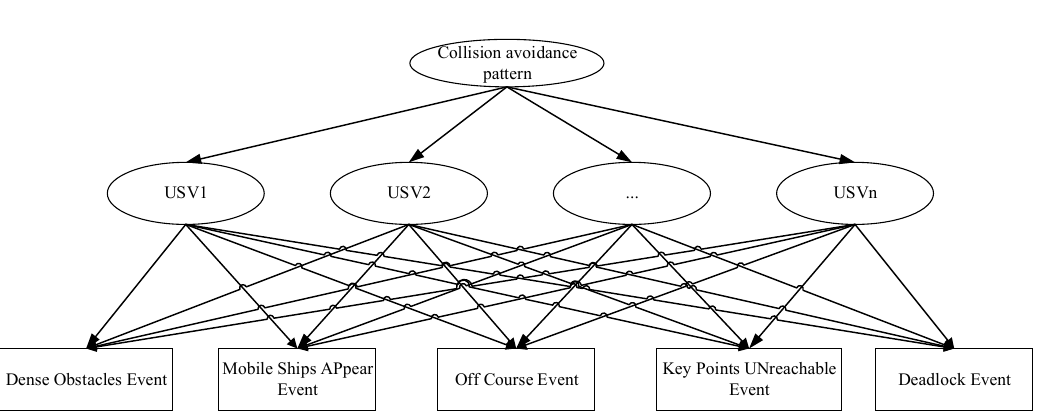
Figure 9. Bayesian network diagram of MUSVs collision avoidance pattern recognition. The Bayesian network conditional probability table and the Bayesian network struc- ture created by writing a C program according to the rules for establishing Bayesian net- works, combined with the contents of the ClassInstance.txt, Condvalue.txt and Proir- value.txt files are shown in Table 2 and Figure 9, respectively. The real-time input infor- mation of the Bayesian network includes not only sensor information, but also initializa- tion information such as conditional probability and prior probability. p (ThreatLevel) = (0.3,0.4,0.3) indicates that the probability of MUSVs overall collision avoidance, group col- lision avoidance or individual collision avoidance is 0.3 for high, 0.4 for medium and 0.3 for low. Table 2. Conditional Probability Table.